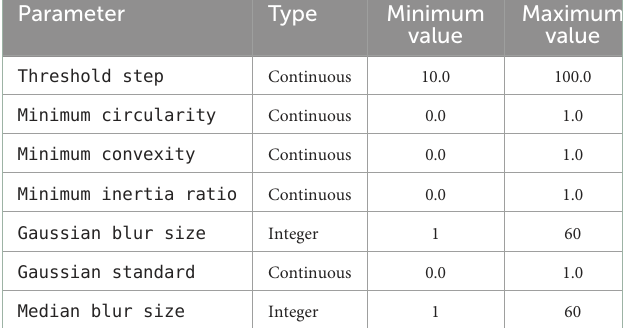
TABLE 4 Parameters in